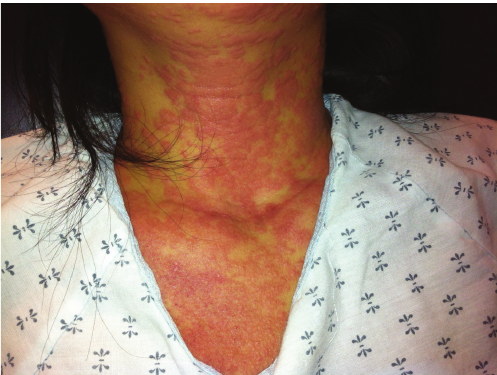
Figure 3: Bilateral wrists/palms: tender, nonblanching red viola- ceous papules and plaques, some with early